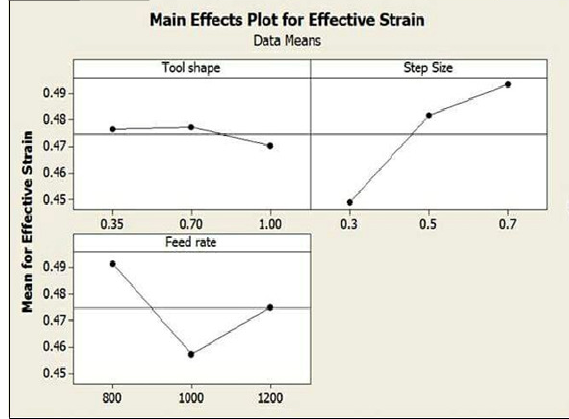
Fig. 16. Main effect plot (Data means) for average effective strains on the 45 ◦ forming angle.